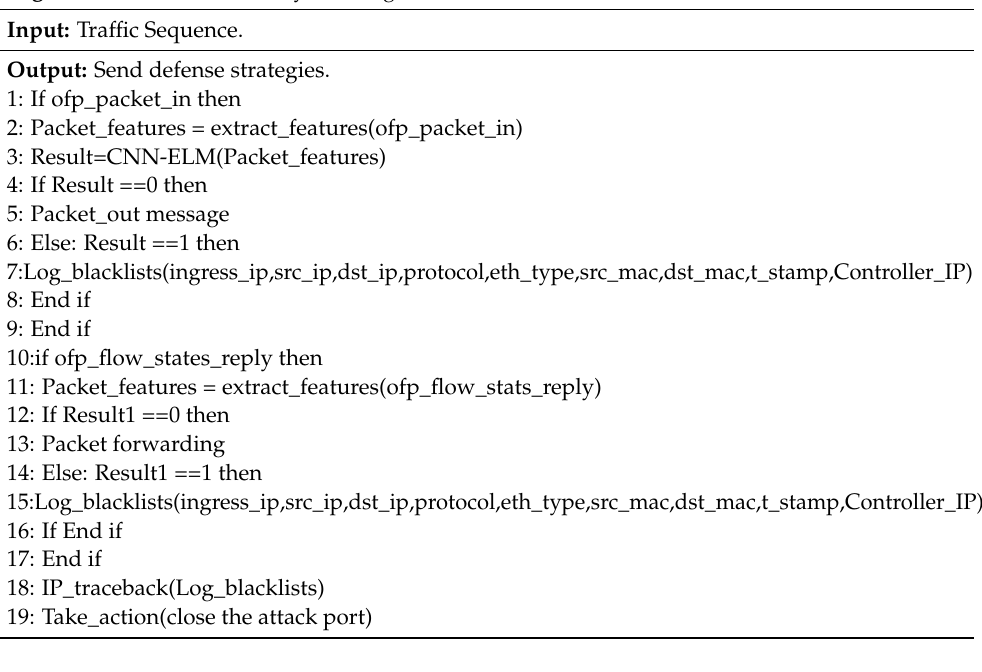
Algorithm 1: SDN Defense System Algorithm